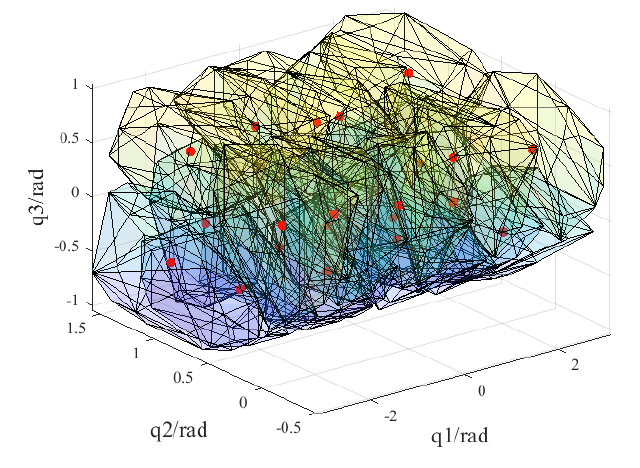
Figure 9. The selected hub configurations.